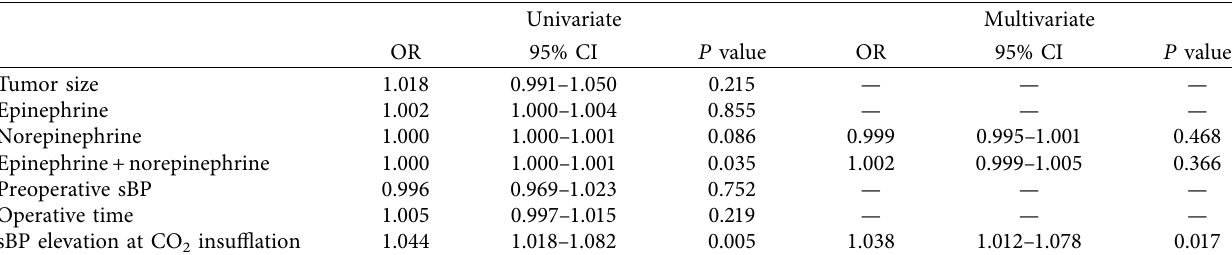
Table 4: Univariate and multivariate analyses of clinical factors for predicting a hypertensive spike in all the